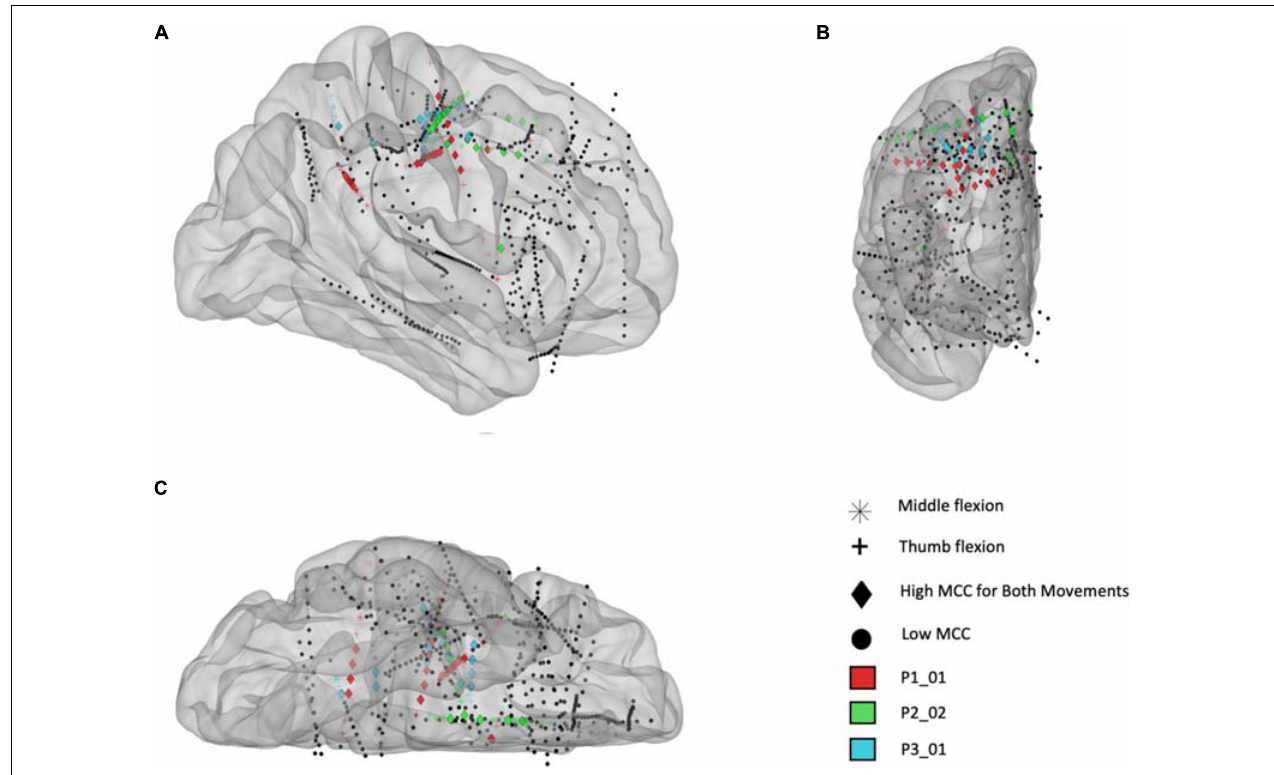
FIGURE 7 | Electrode locations (right hemisphere) mapped to standard brain based on the Yeo 7 atlas for participants P1_01 (red), P2_02 (green), and P3_01 (blue). (A) Sagittal view from lateral perspective. (B) Coronal view from anterior perspective. (C) Transverse view from inferior perspective. The colored electrodes had high temporal correlation (MCC > 0.6) during a cued finger task including sustained thumb and middle flexion movements, separately, and the symbols mark which movement(s) had high MCC values: thumb flexion (cross), middle finger flexion (asterisk), or both (diamond). Note: electrodes are sometimes not inserted fully by the surgeon, therefore some contacts are located outside the brain (as seen in this